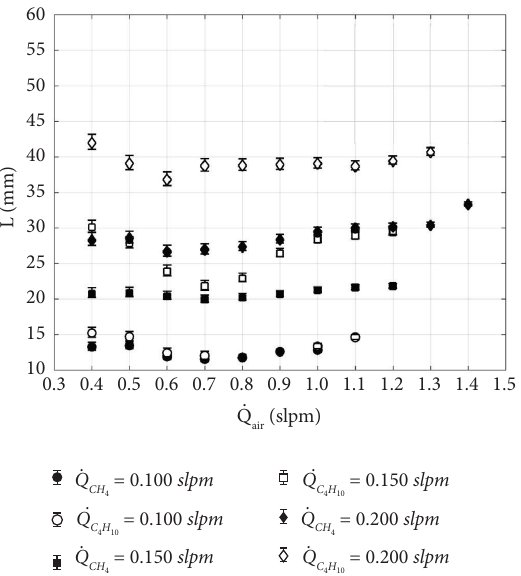
Figure 12: Variation of fame length with airfow rate for methane and n-butane.